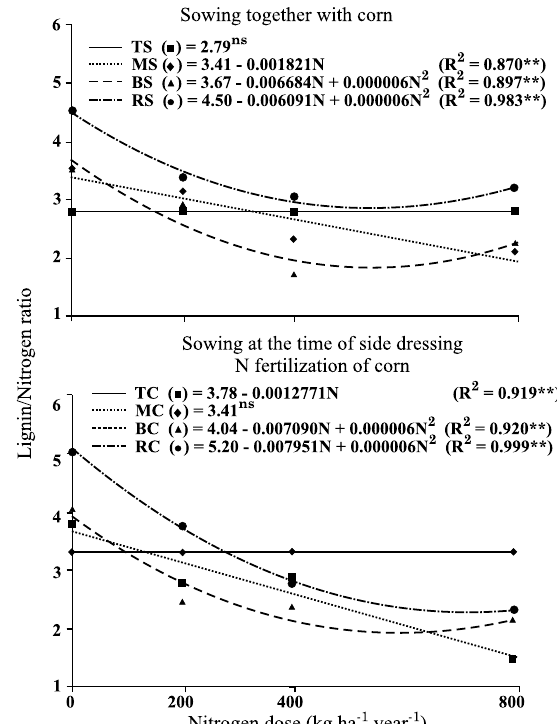
Figure 2. Lignin/Nitrogen ratio of straw of Panicum maximum cv. Tanzânia, P. maximum cv. Mombaça, Brachiaria brizantha cv. Marandu and B. ruziziensis grown intercropped with maize, N- fertilized (split in four applications at harvest) and chopped after the last cut of